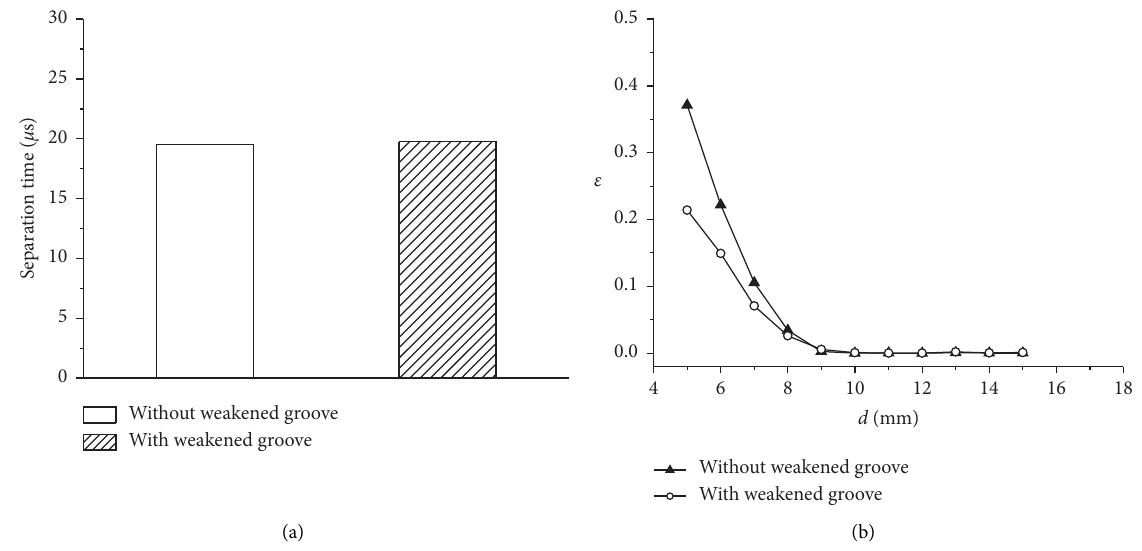
Figure 7: Influence of weakening groove on cutting results: (a) separation time; (b)